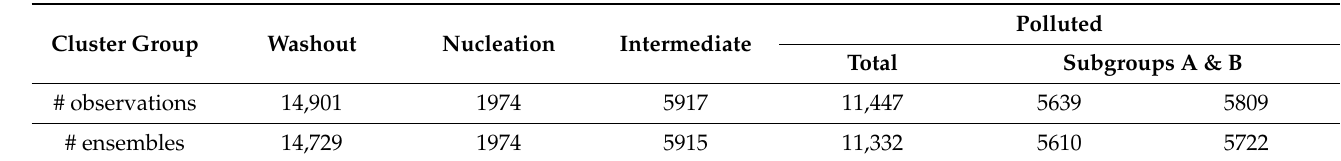
Table A1. Total number of observations and trajectory ensemble runs for each of the clustered groups and the two subgroups.